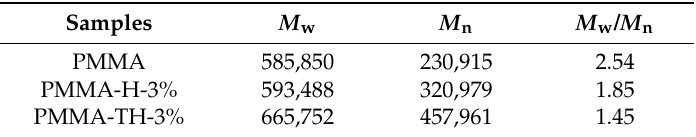
Table 1. Average molecular weights and polydispersity of the molecular weight distribution of PMMA and PMMA/reactive halloysite